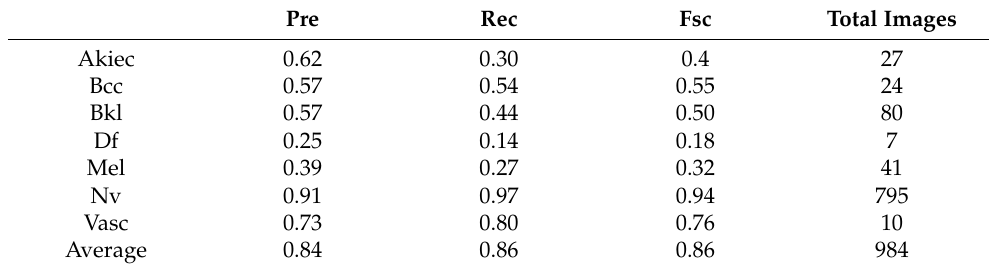
Figure 13. Example of testing classification phase. Table 5. Detailed results for each class using CNN learning model.